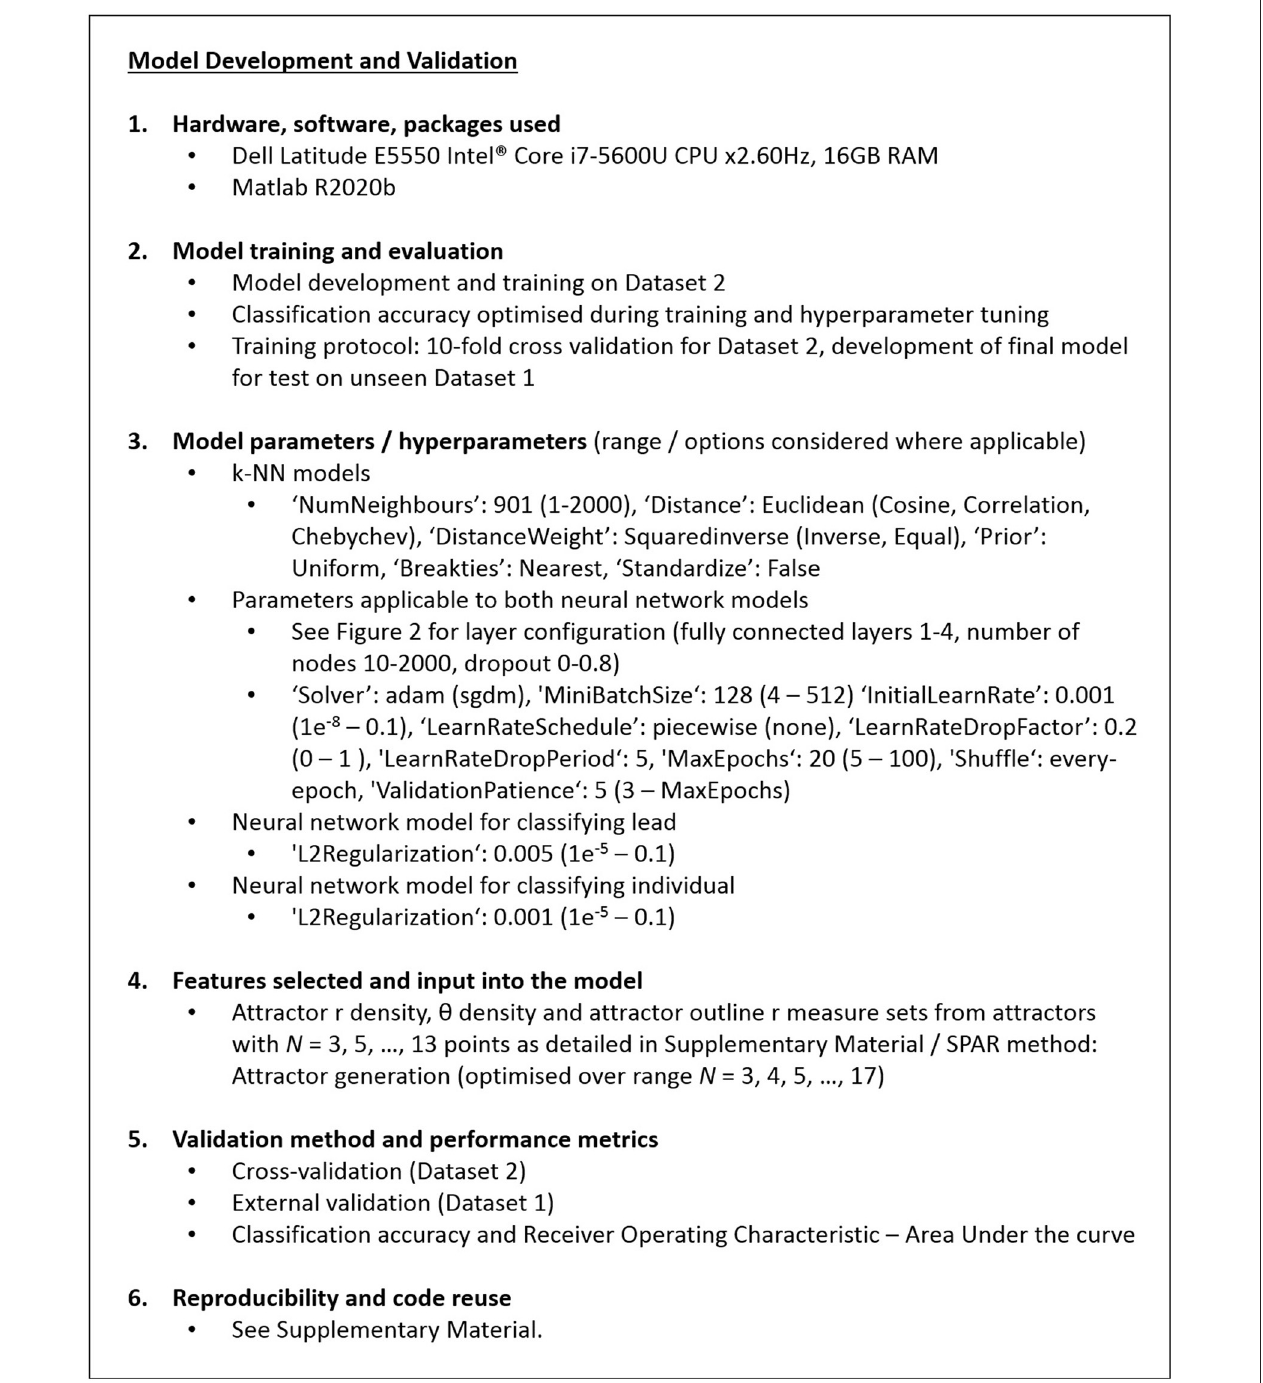
FIGURE 4 | Detail of the machine learning model development and validation. The machine learning model parameters and hyperparameters are set to those given, with the values in brackets being the ranges/options considered during optimization of the model.